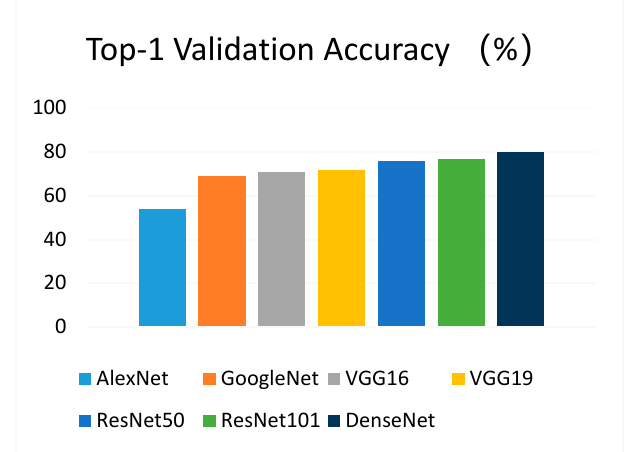
Figure 5. Comparison of the pretrained models.